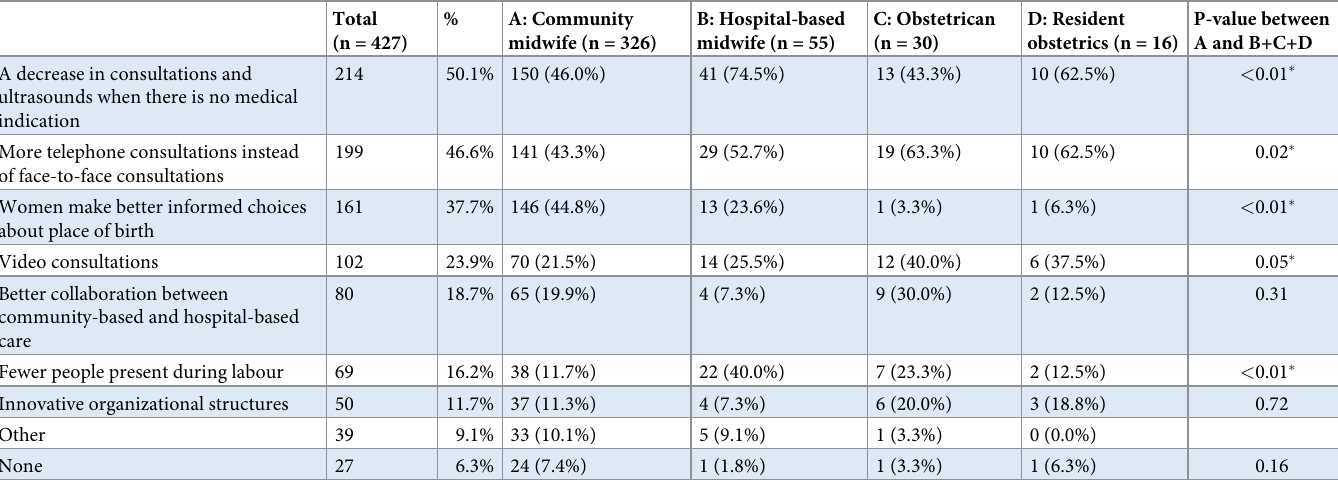
Table 4. Opportunities for the organization of maternity care in the